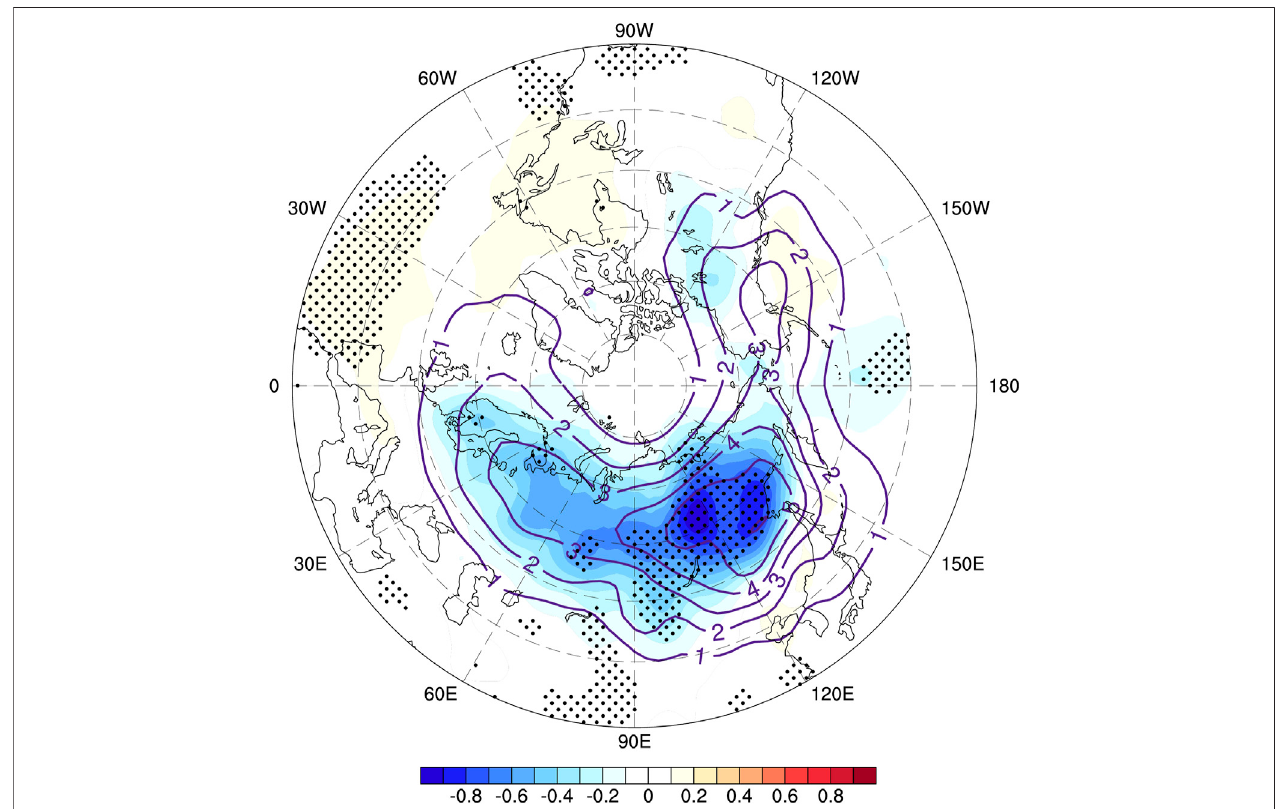
FIGURE 4 | Regression of October vertical wave activity fl ux (WAF) anomalies (shading; 10 − 3 m 2 s − 2 ) at 50 hPa against the negative October SNOWI during 1979 – 2017. Contours denote the climatological mean of 50 hPa vertical WAFs in October. Stippled regions indicate that the anomalies are signi fi cant at the 90% con fi dence